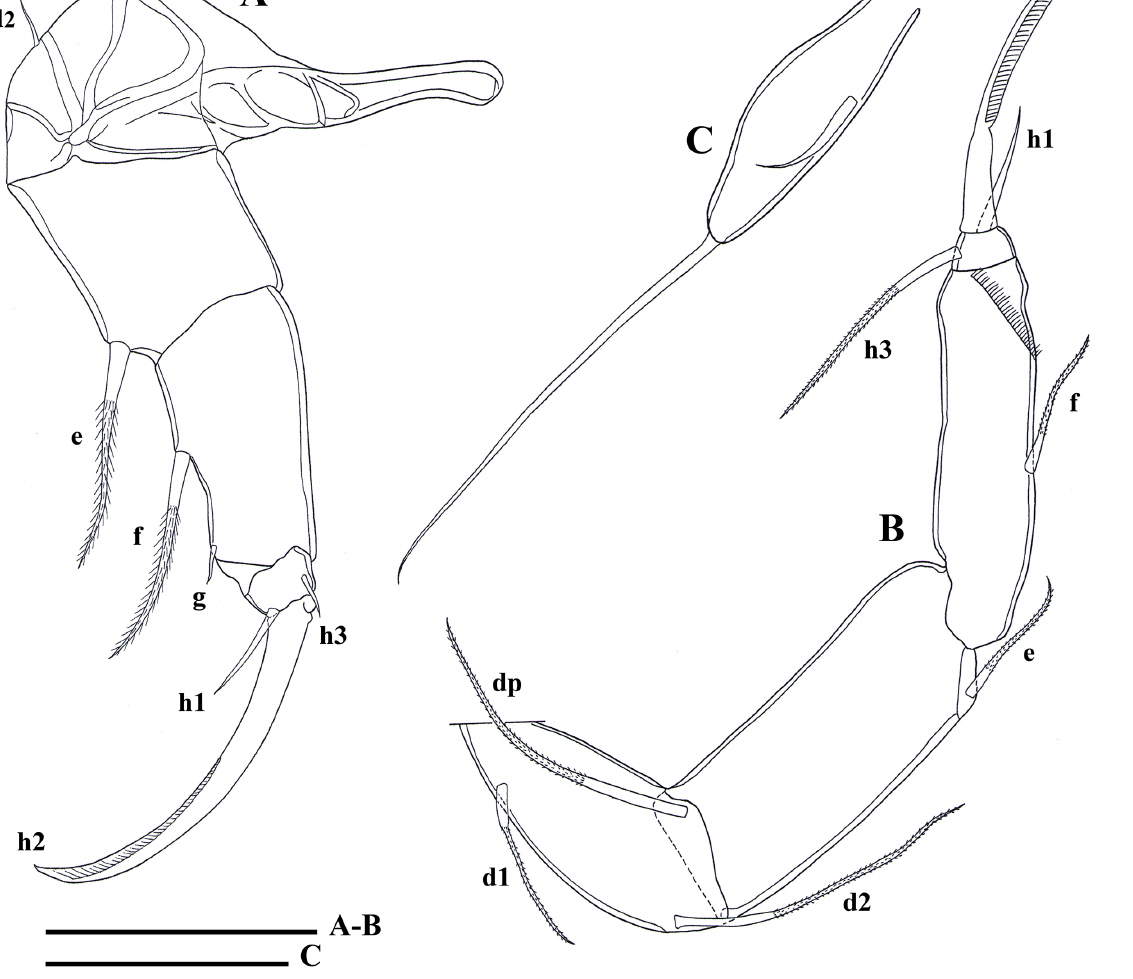
Fig. 5. Cyprettadopsis sutura gen. et sp. nov., ♀ (MSU-ZOC.267). A . T2. B . T3. C . CR. Scale bars: A = 50 μm; B = 40 μm; C =